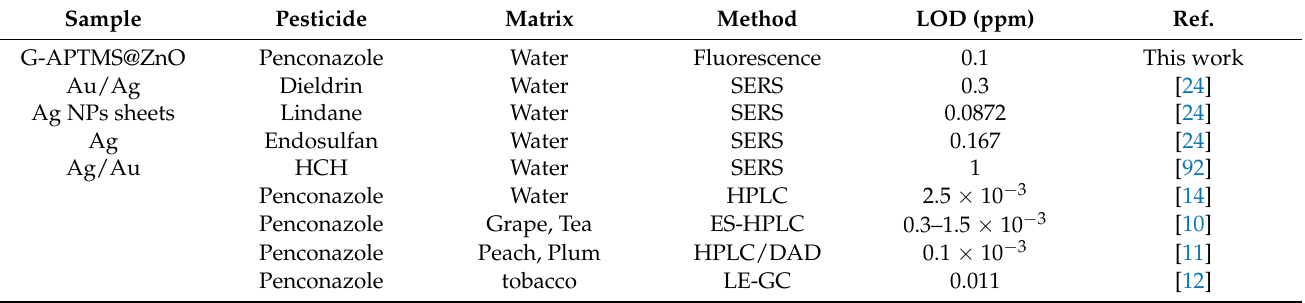
Table 6. LODs of penconazole detected by HPLC in various matrices and OCPs by SERS. LE = Liquid Extraction, DAD = Diode Array Detector, ES =